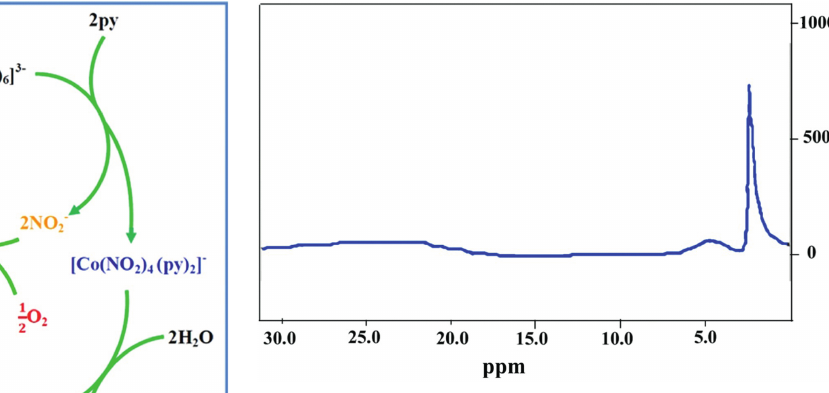
Figure 2: 1 H NMR spectrum of [Co(py) 2 (H 2 O) 2 (NO 3 ) 2 ] in D 2